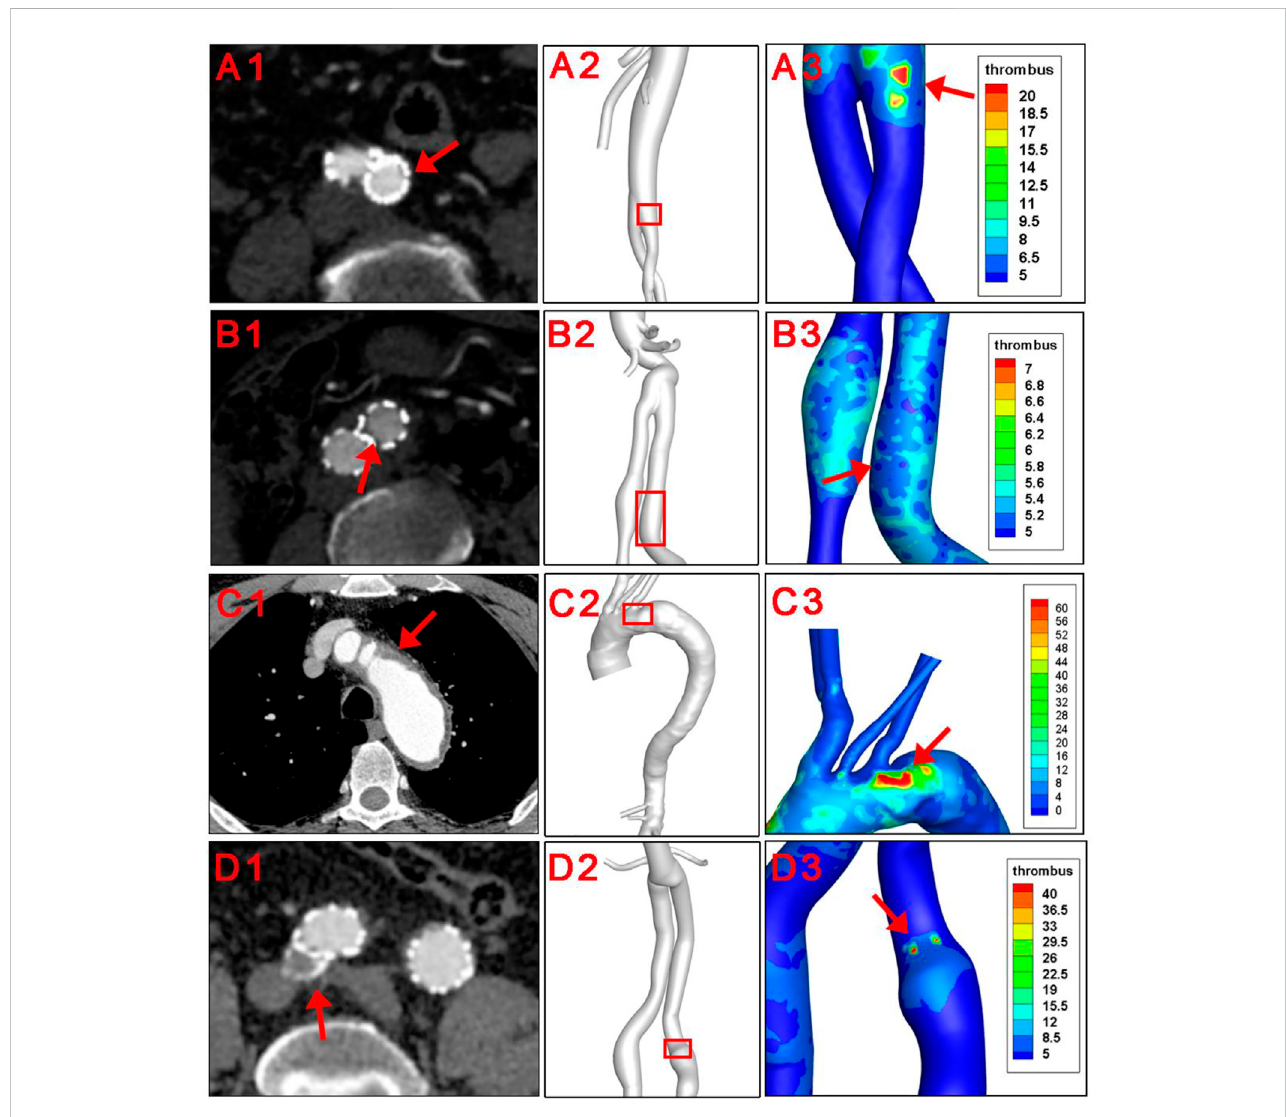
Clinical veri fi cation of the thrombus forming model. Red arrows and red squares indicated places of thrombus formation on CTA images and corresponding 3D